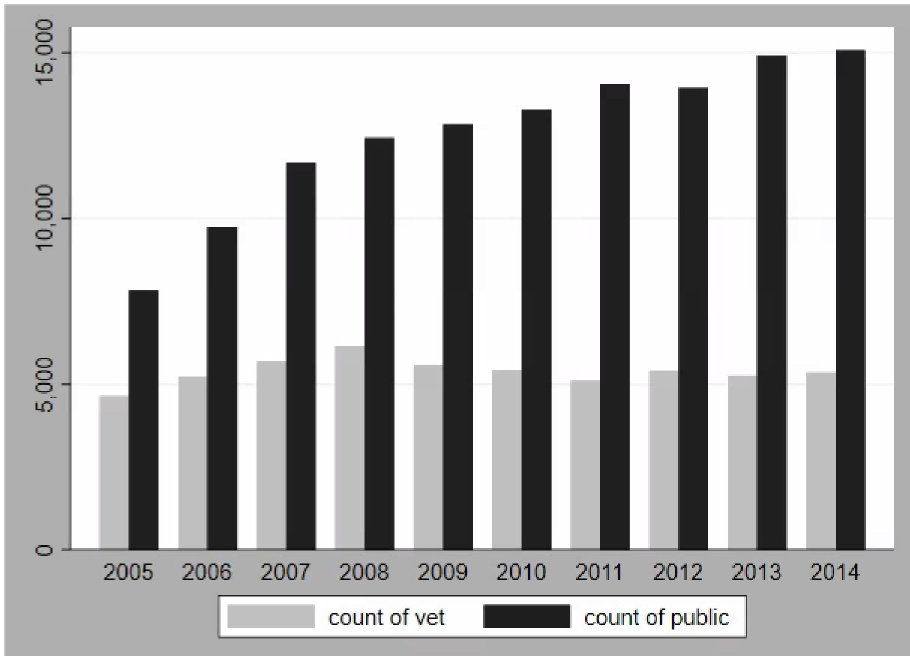
Fig 1. Total calls to the APCC by caller type (veterinarian & public) and year the call was received (2005–2014).